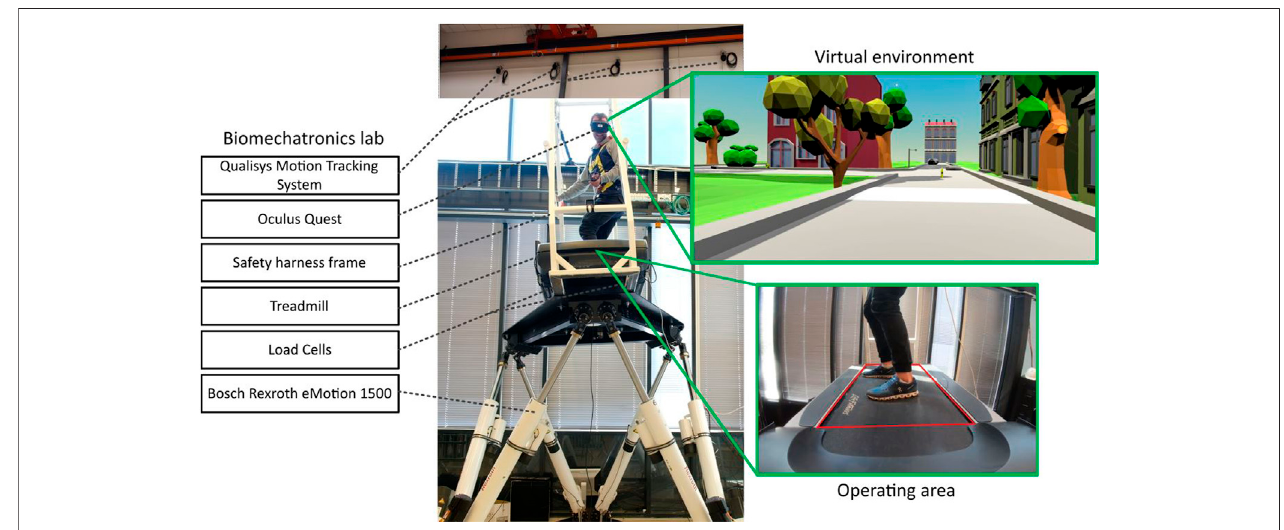
FIGURE 1 | Biomechatronics lab.